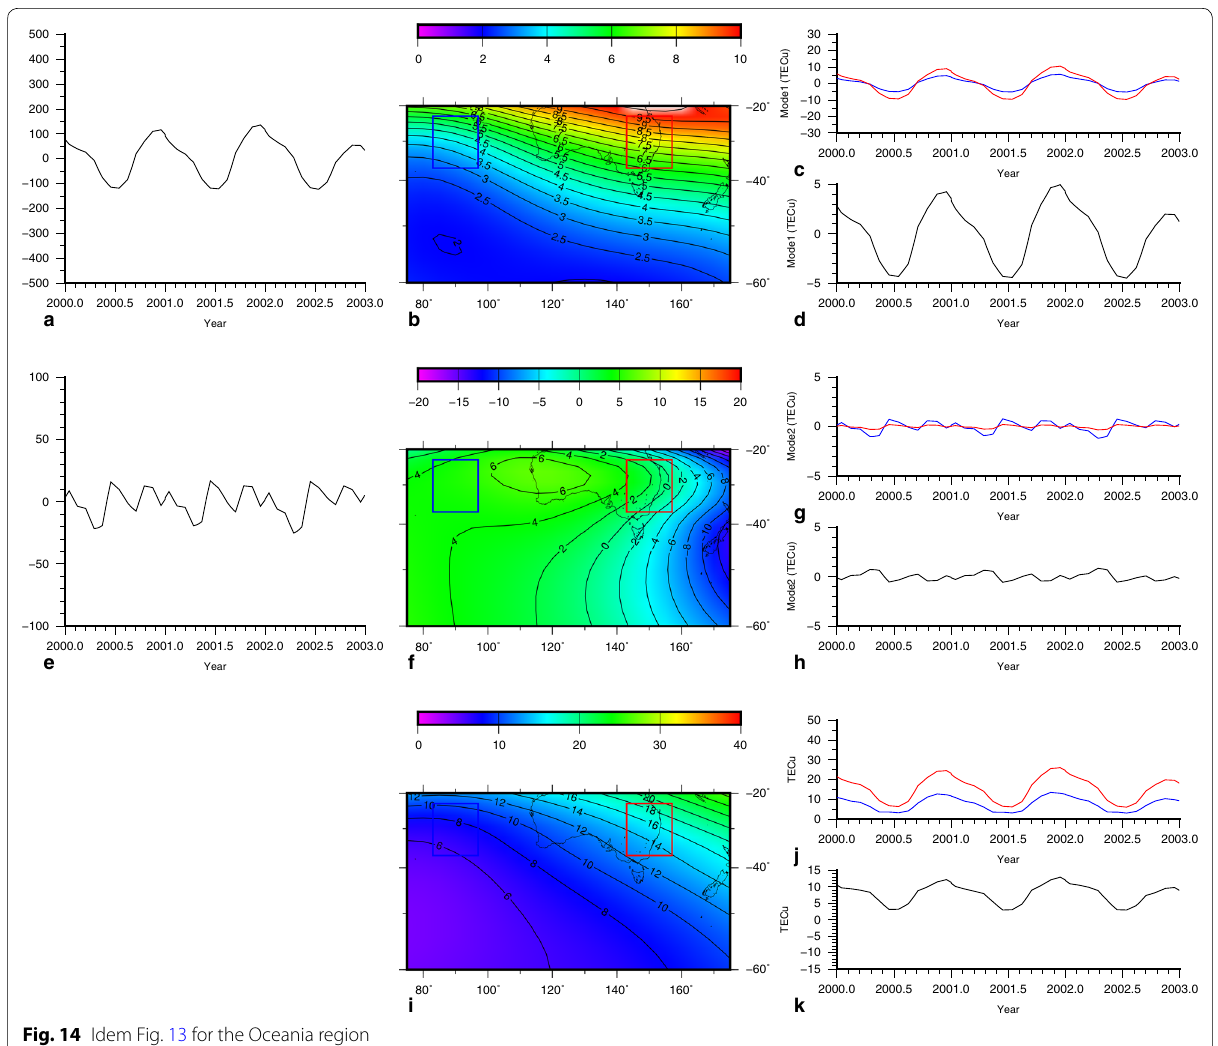
Fig. 14 Idem Fig. 13 for the Oceania region